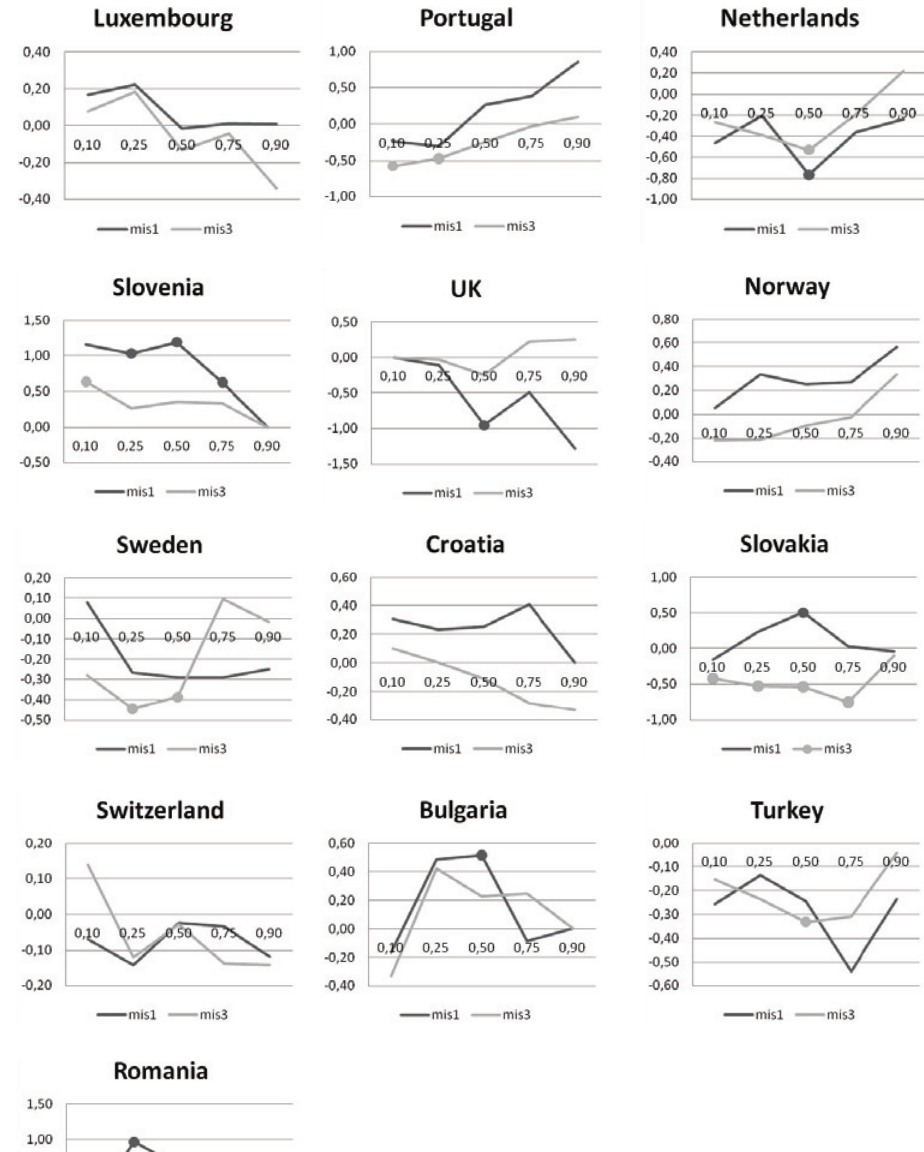
Fig. 1. Set of figures with the evolution of coefficients for under-skilling (mis1) and over-skilling (mis3) throughout the wage distribution for each country. Bullets in the graphs indicate statistically significant estimates (10% or higher level of